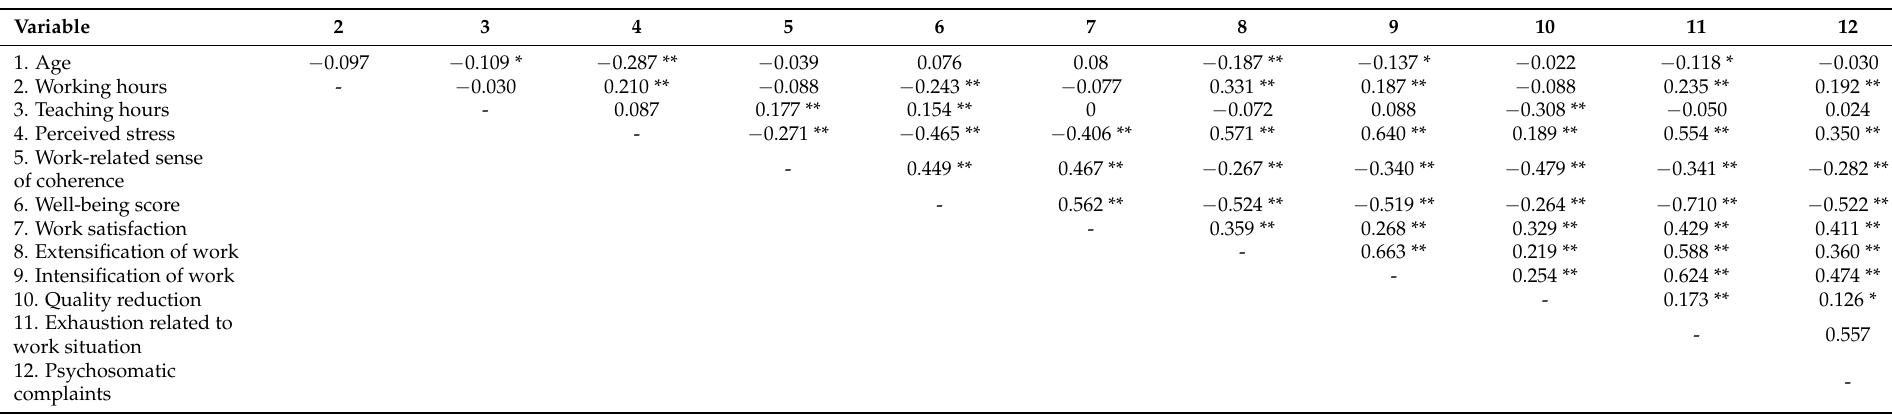
Table 3. Intercorrelations between key